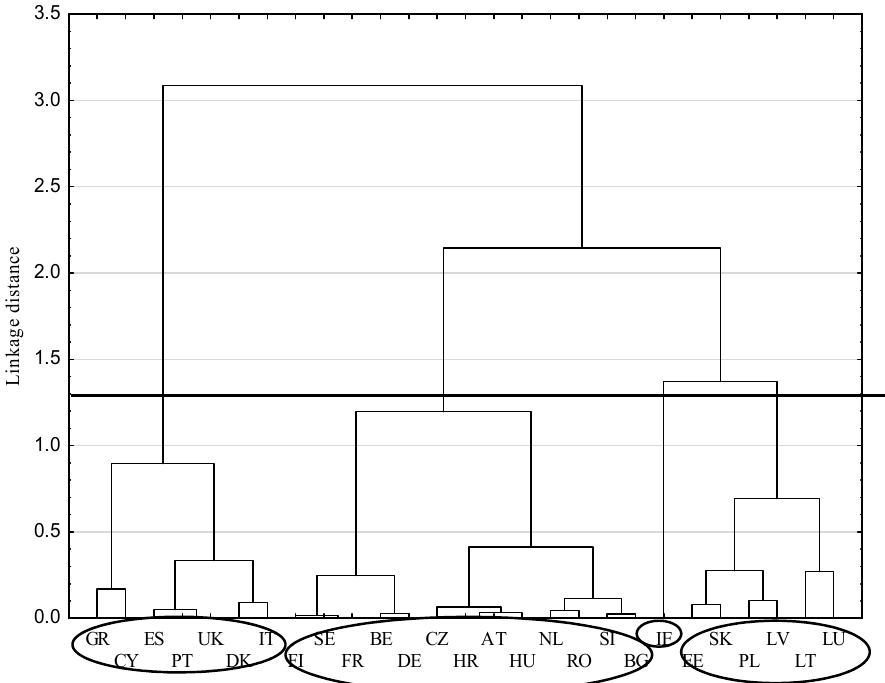
Figure 1. The results of Ward’s method. Source: personal elaboration.